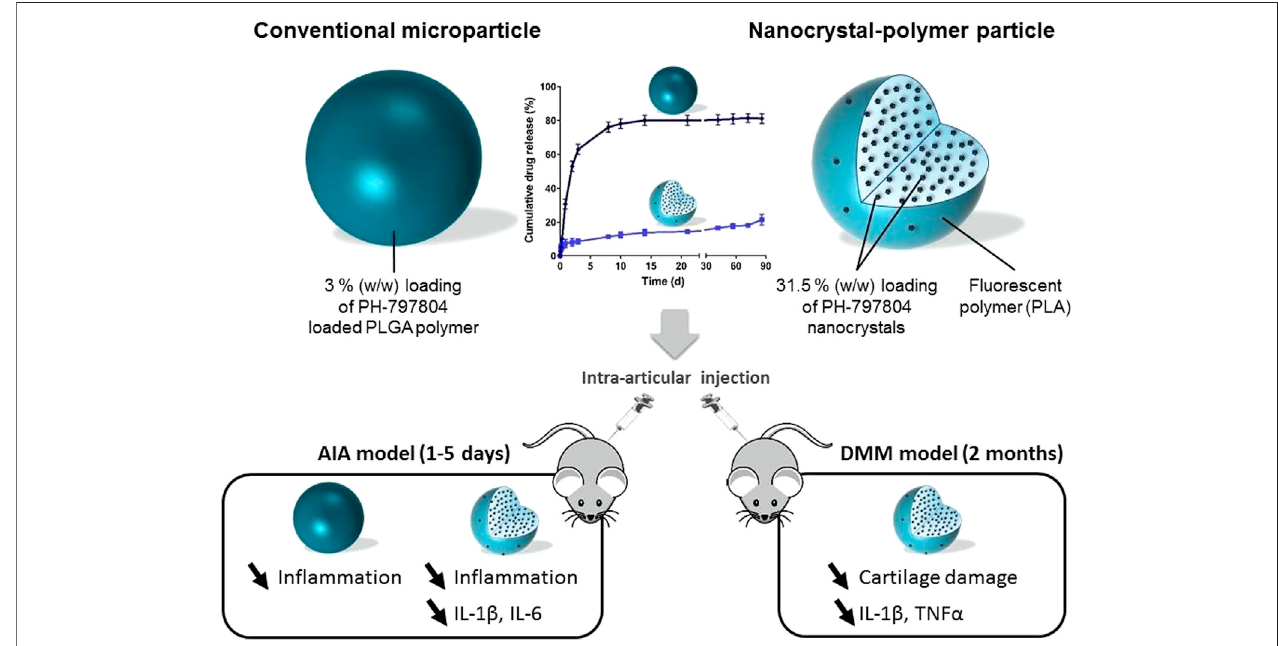
Outcome Delivery route